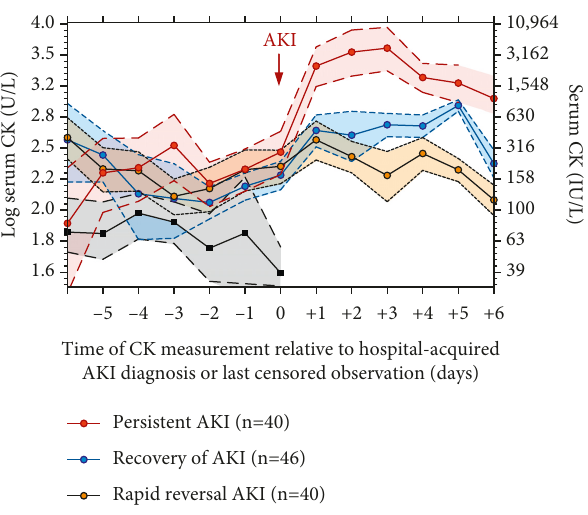
Figure 2: Longitudinal trajectory of serum CK measurements relative to the time of hospital-acquired AKI evolution or last censored observation. Red, blue, orange, and black represent means of log serum CK concentrations (a) or CK concentrations in IU/L (b) for subjects with persistent AKI, rapid reversal AKI, and recovery AKI and without AKI, respectively; 95% confidence intervals are represented in shaded areas.